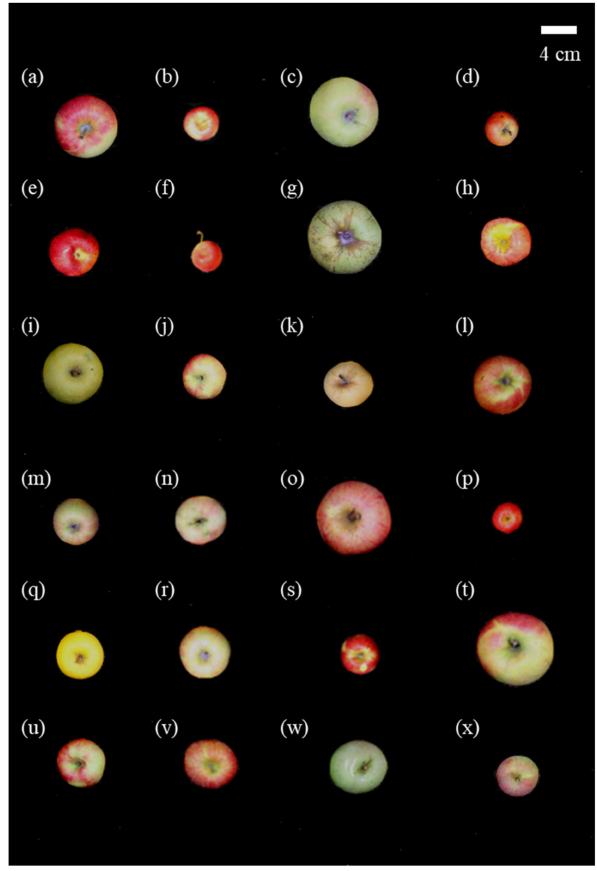
Figure 1. Images of apples of the 24 apple cultivars ( a ) Summer Prince, ( b ) Ruby-S, ( c ) Summer King, ( d ) Tinkerbell, ( e ) Arisoo, ( f ) Decobell, ( g ) Green Ball, ( h ) Honggeum, ( i ) Hwangok, ( j ) Picnic, ( k ) Gala, ( l ) Sansa, ( m ) Tsugaru, ( n ) Hongro, ( o ) Sekaiichi, ( p ) Alps Otome, ( q ) Golden Delicious, ( r ) Jonagold, ( s ) Jonathan, ( t ) Kamhong, ( u ) Yoko, ( v ) Fuji, ( w ) Indo, and ( x ) Ralls